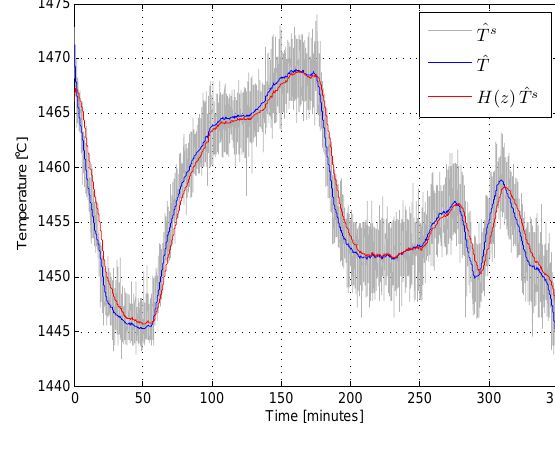
Figure 14: Bode diagram of ˜ G ( z ). Figure 15: The output of the sensor fusion algorithm,